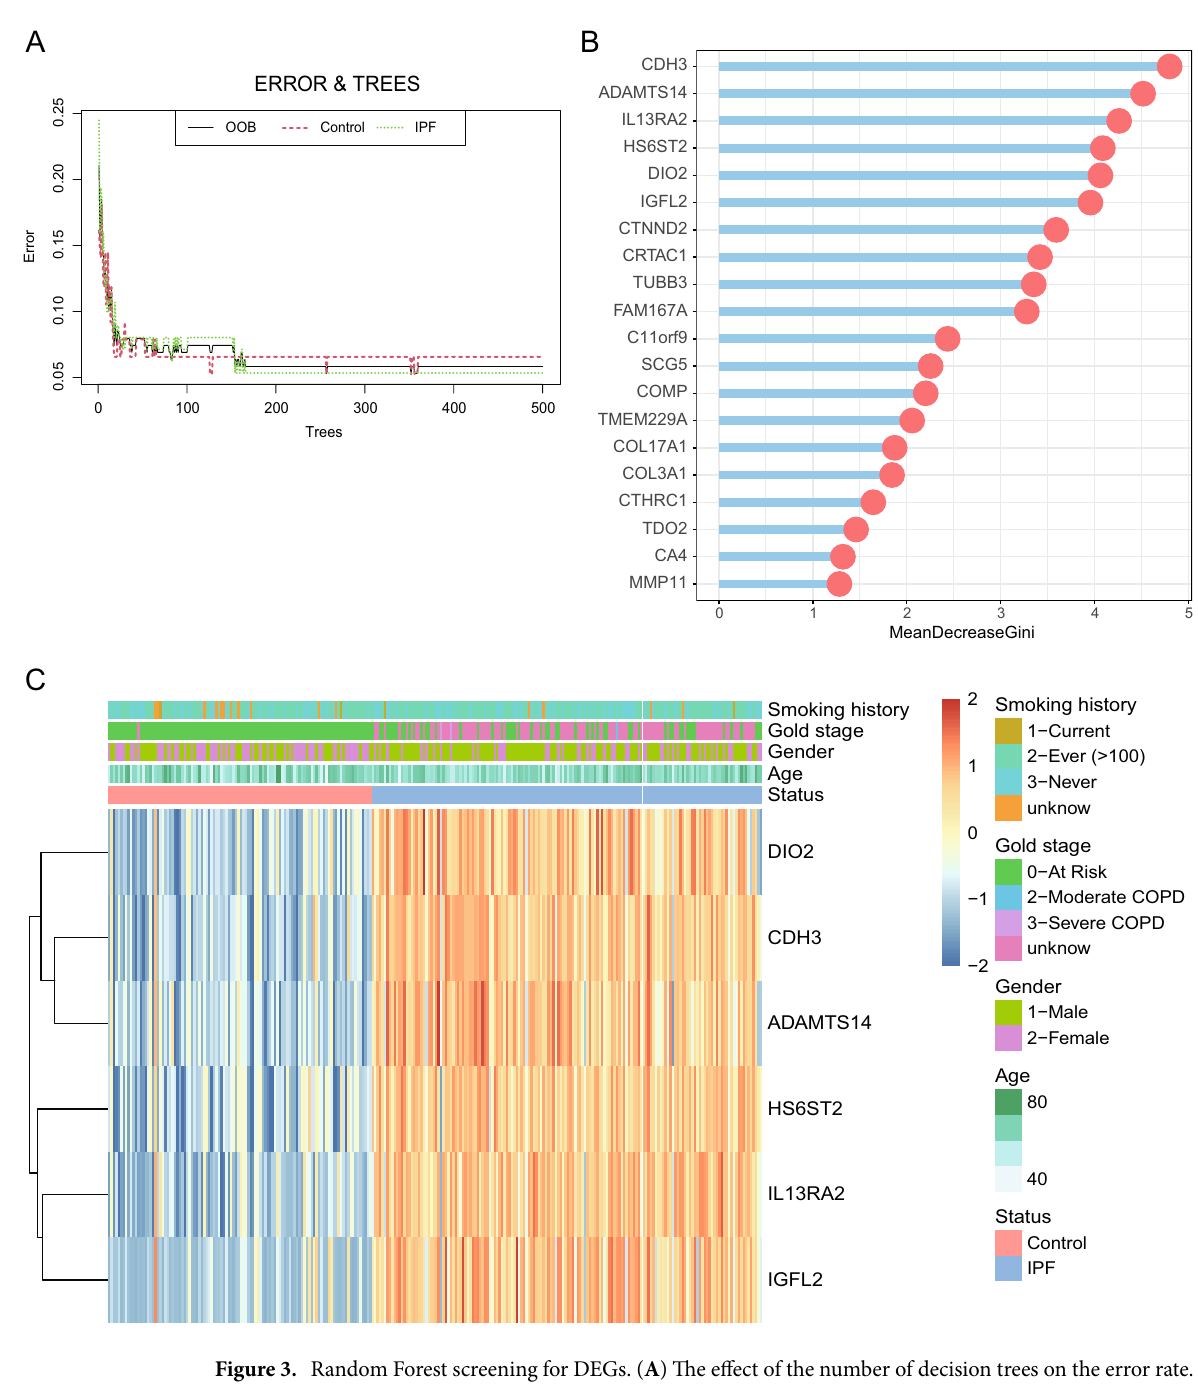
Figure 3. Random Forest screening for DEGs. ( A ) The effect of the number of decision trees on the error rate. The x-axis represents the number of decision trees, and the y-axis represents the error rate. When the number of decision trees is about 500, the error rate is relatively stable. ( B ) Results of the Gini coefficient method in the random forest classifier. The x-axis represents the importance index, and the y-axis represents the genetic variables. Rank and display the top 20 genes of importance coefficient. ( C ) The unsupervised clustering heatmap shows the hierarchical clustering results generated from six significant genes generated by a random forest in GSE47460. On the upper part of the heatmap, the red band in the status module represents normal samples, and the blue band represents disease samples; the color in the age module gradually changes from white to green, representing the increasing age of the sample; the light green band in the gender module represents male samples, the purple strip represents female samples; the green strip in the gold stage module means AT Risk, the green strip means Moderate COPD; the purple strip means Severe COPD; the rose-red strip means unknown; the yellow strip in the smoking history module means the current still Smoking; green strips have ever smoked; blue strips have never smoked; orange strips are